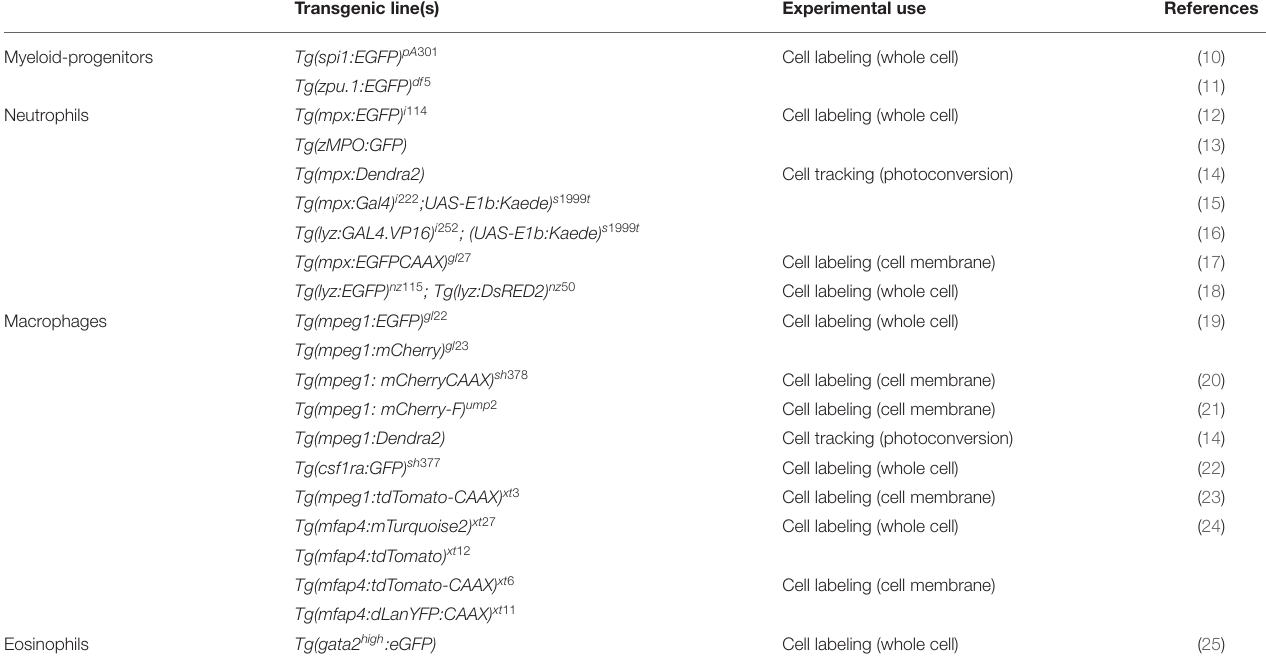
TABLE 1 | Examples of transgenic lines routinely used to visualize phagocytes in larval zebrafish. Transgenic line(s) Experimental